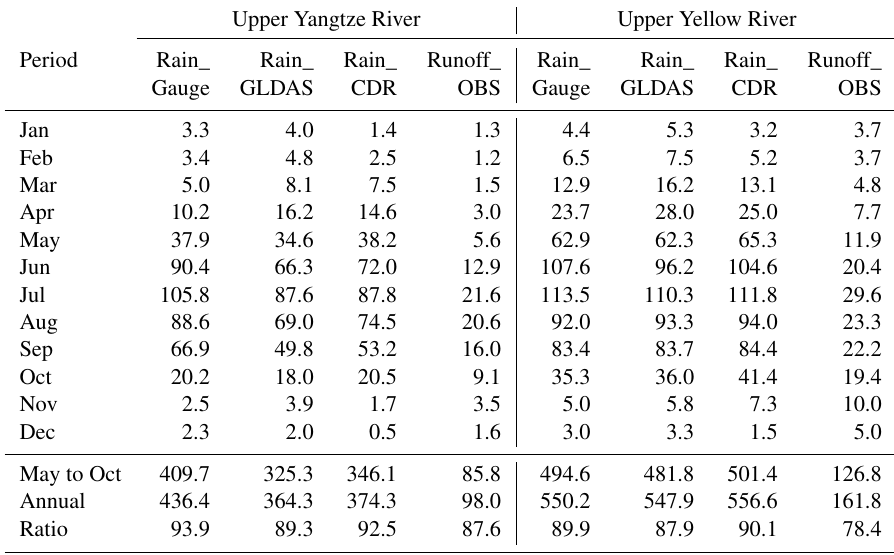
Table 2. Average monthly precipitation and runoff in the upper Yangtze and Yellow River